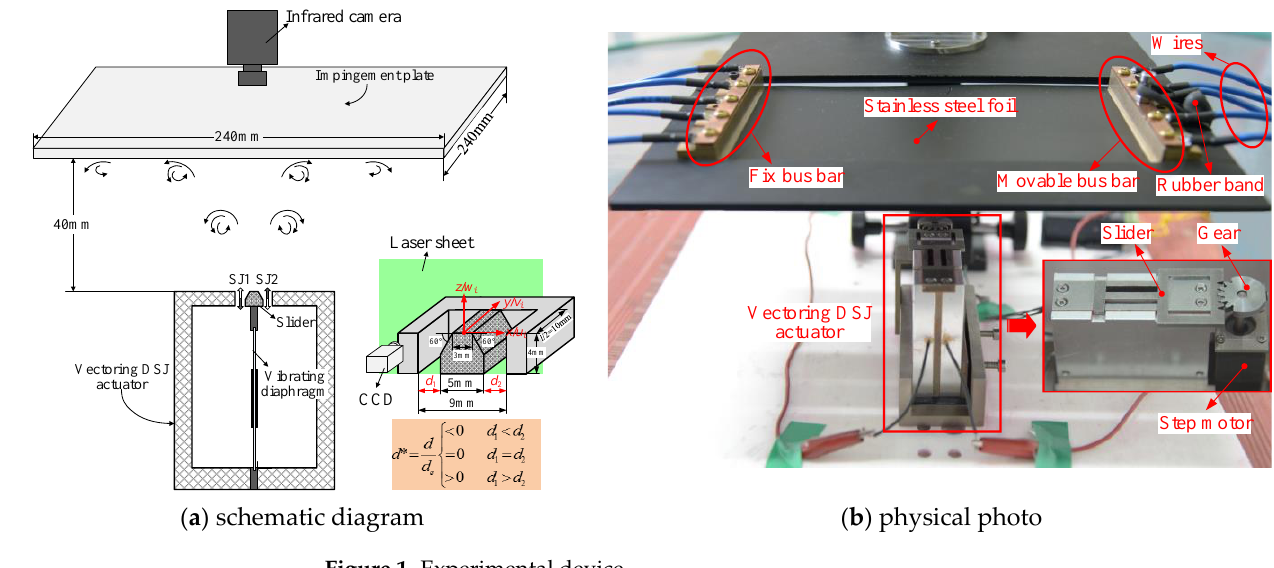
Figure 1. Experimental device.